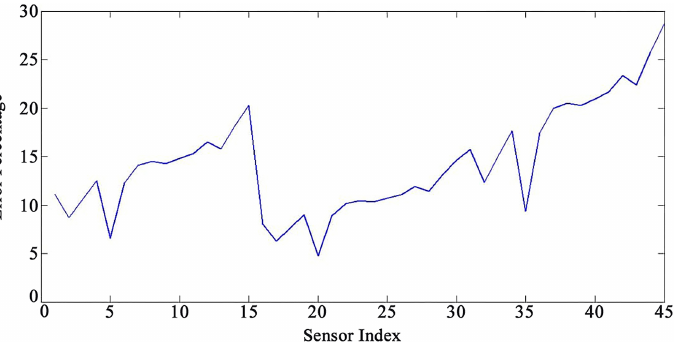
Figure 7. Error percentage for each sensor under loading number 1 (15-degree attack angle).